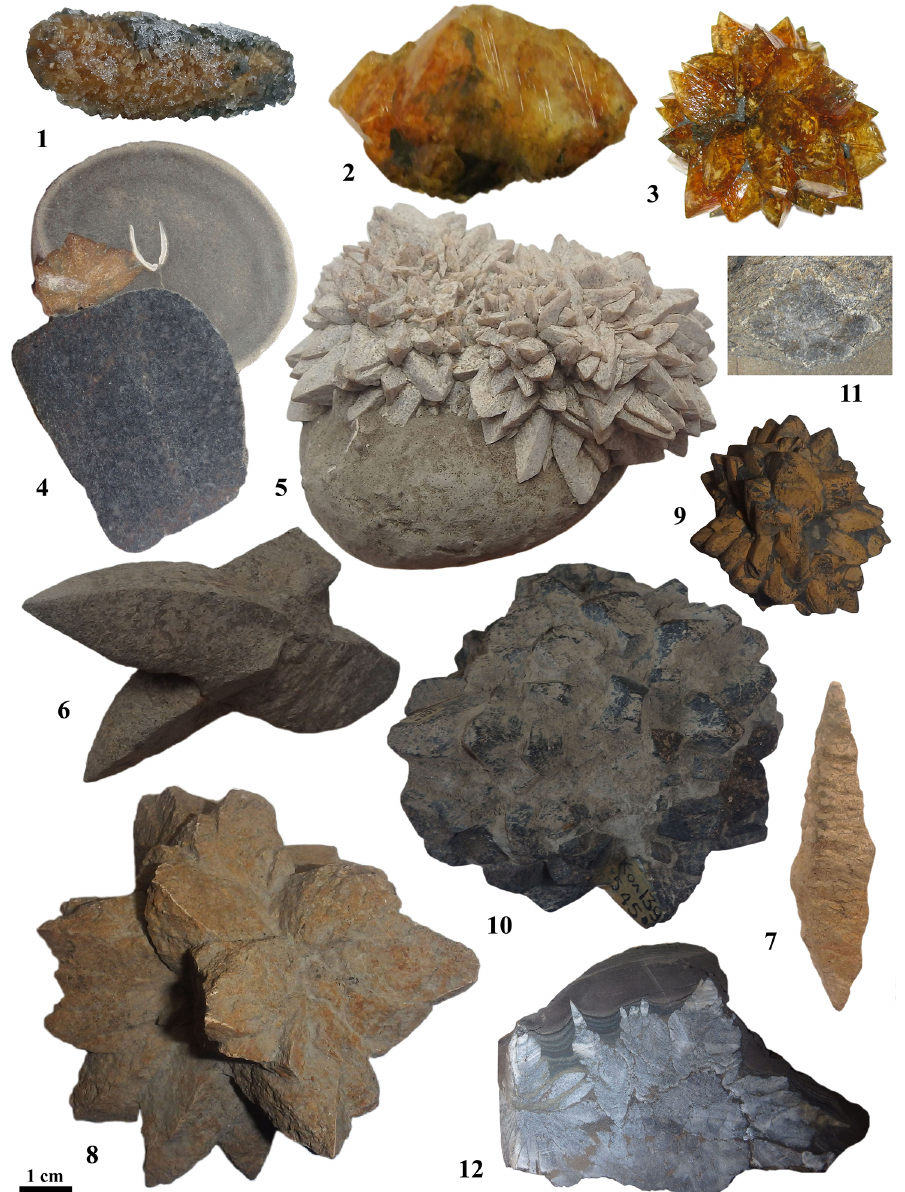
Figure 1. Ikaite and glendonite morphology (all specimens are shown at natural size). Abbreviation for museum collections: FMM –